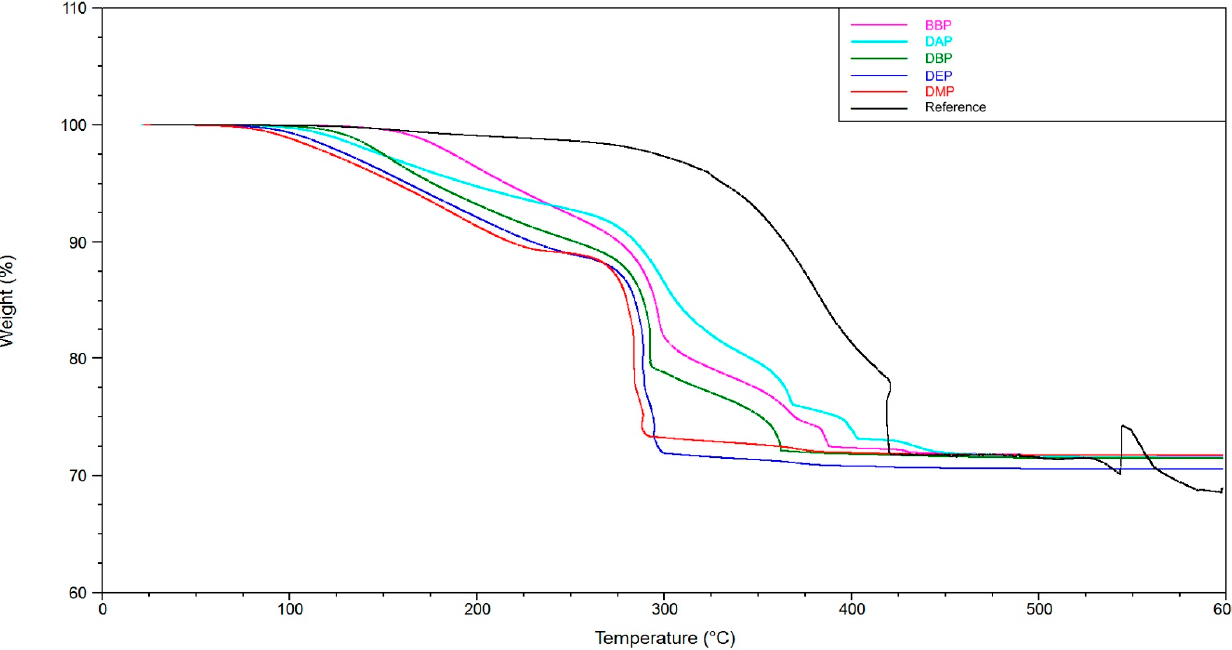
Figure 13. Thermomechanical analysis of green bodies produced by LCM using different phthalate suspensions .